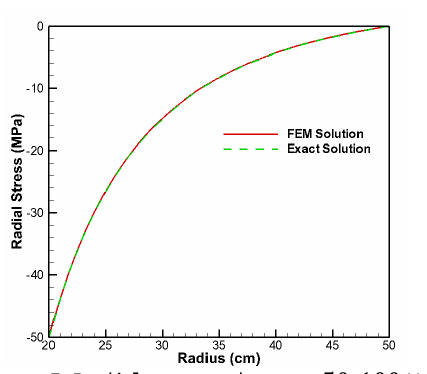
= 50, 100 MPa Figure 6. Tangential stress under 𝑞 𝑖